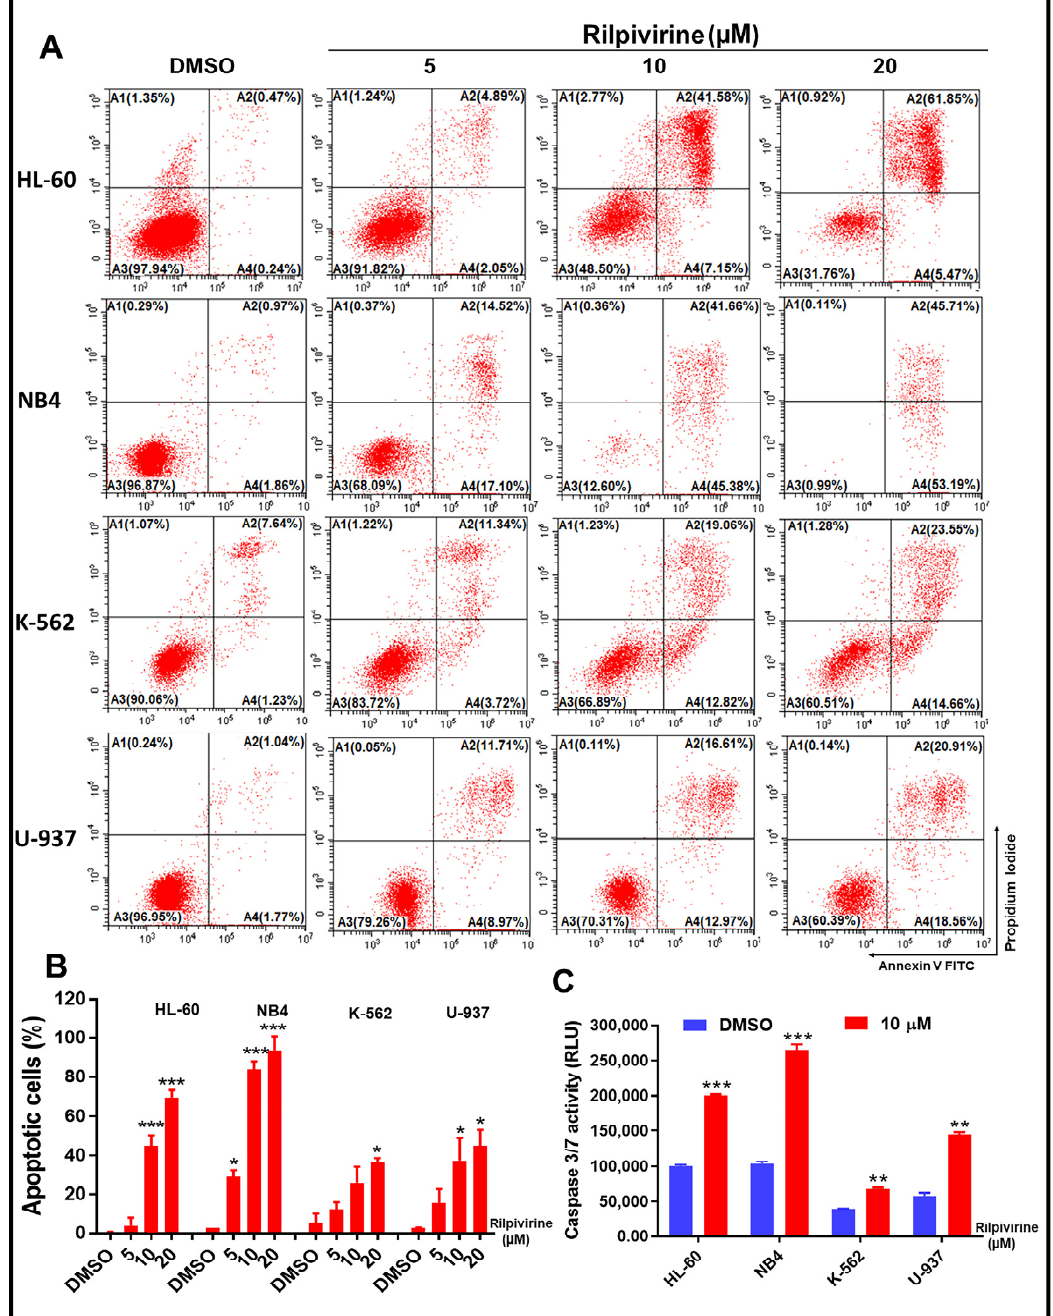
Figure 4. Effect of rilpivirine on apoptosis of leukaemic cells. HL-60, NB4, K-562, and U-937 cells were treated with rilpivirine for 48 h at the indicated concentrations and apoptosis was detected using annexin V/PI double staining. ( A ) Representative figures from flow cytometric analysis are shown. ( B ) The percentages of apoptotic cells at indicated concentrations. ( C ) The activity of caspase 3/7 in cells after incubation with 10 µM rilpivirine for 48 h. Data (mean ± SD) were presented from three independent experiments (* p < 0.05, ** p < 0.01, and *** p < 0.001).